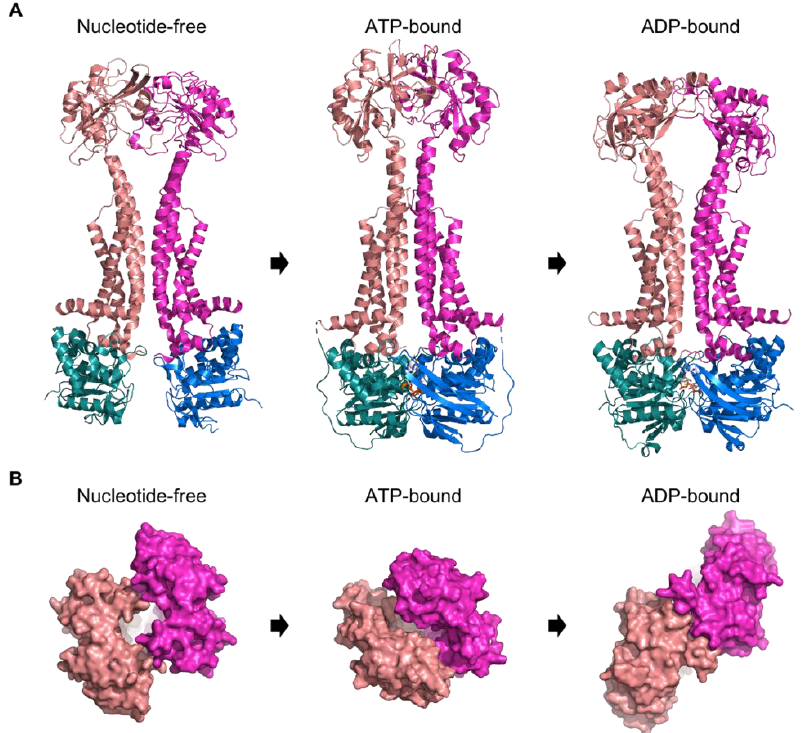
Figure 5. Structures of MacB in a nucleotide-free (PDB entry 5NIL), ATP-bound (PDB entry 5LIL), and ADP-bound (PDB entry 5WS4) state. NBDs are shown in deep teal and marine, and the TMDs with the periplasmic part are shown in salmon and light magenta. ( A ) : Side view of MacB in the different nucleotide-free/-bound states. ( B ) : Top view of the periplasmic part of MacB in the different nucleotide-free/-bound states.